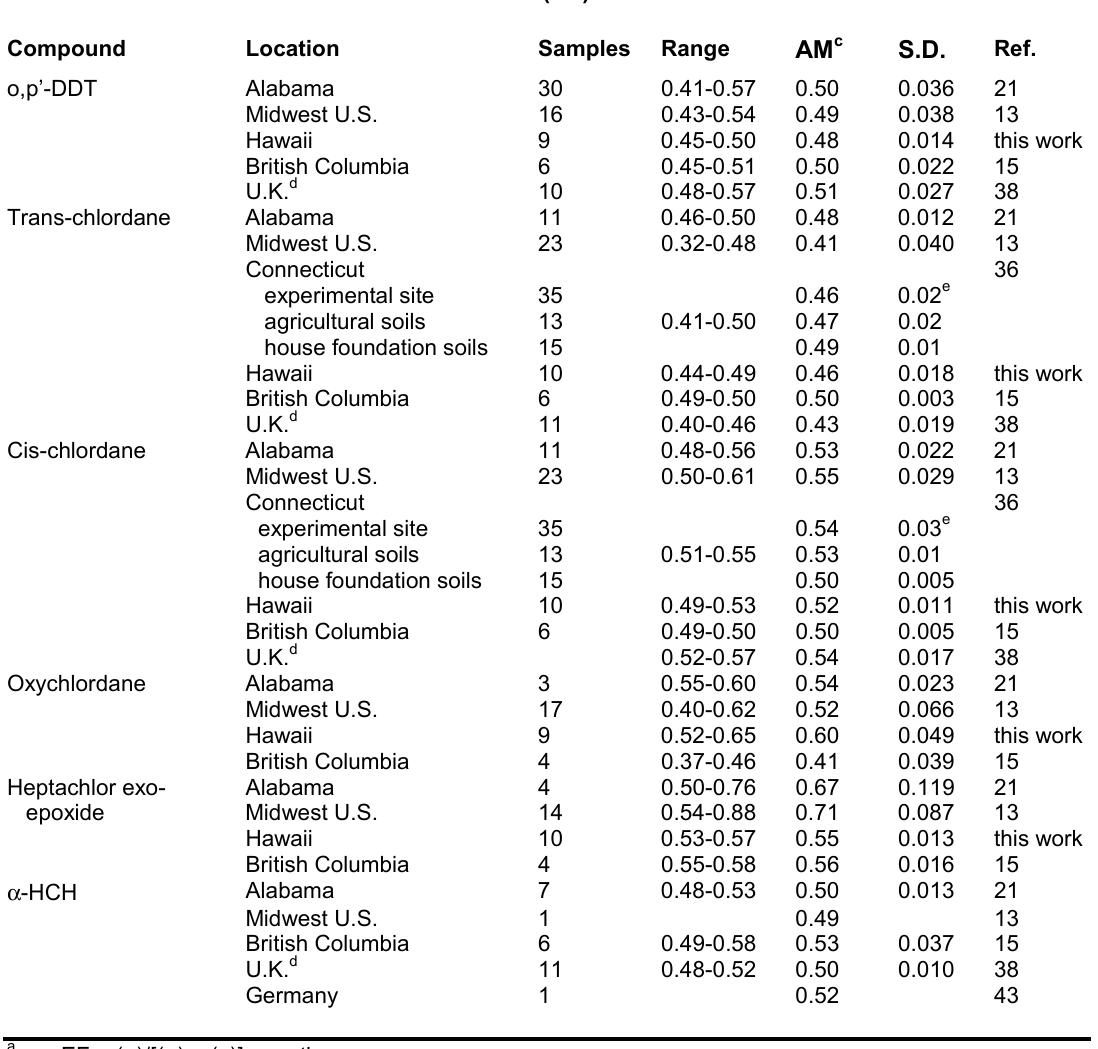
Enantiomer Fractions (EF) of OCPs in Soils